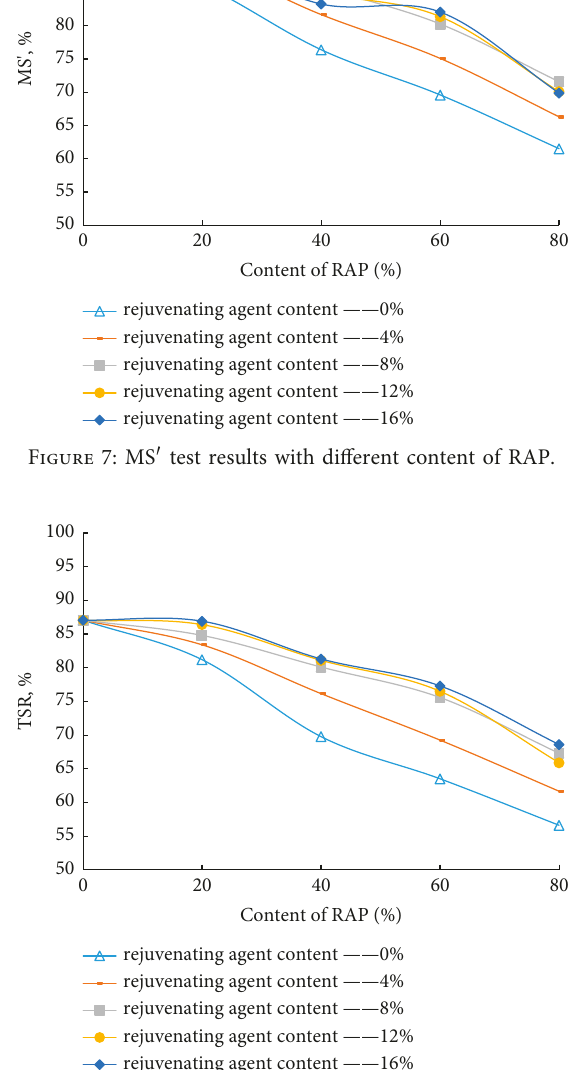
Figure 6: Failure strain test results with different content of RAP.